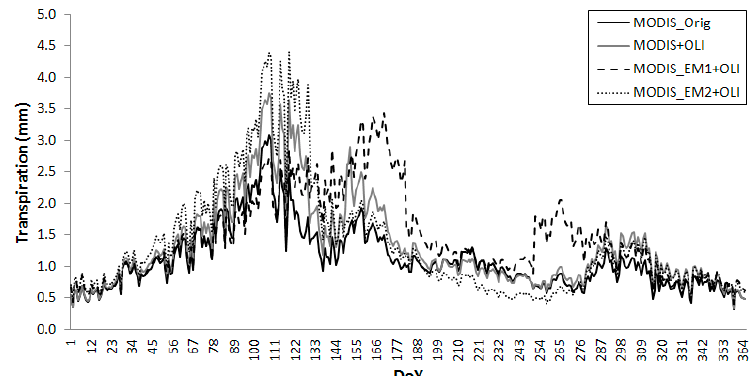
Figure 5. Daily olive tree transpiration estimated by the NDVI-Cws method driven by the different NDVI multitemporal profiles (the data series are the same as in Figure 4, see text for details).